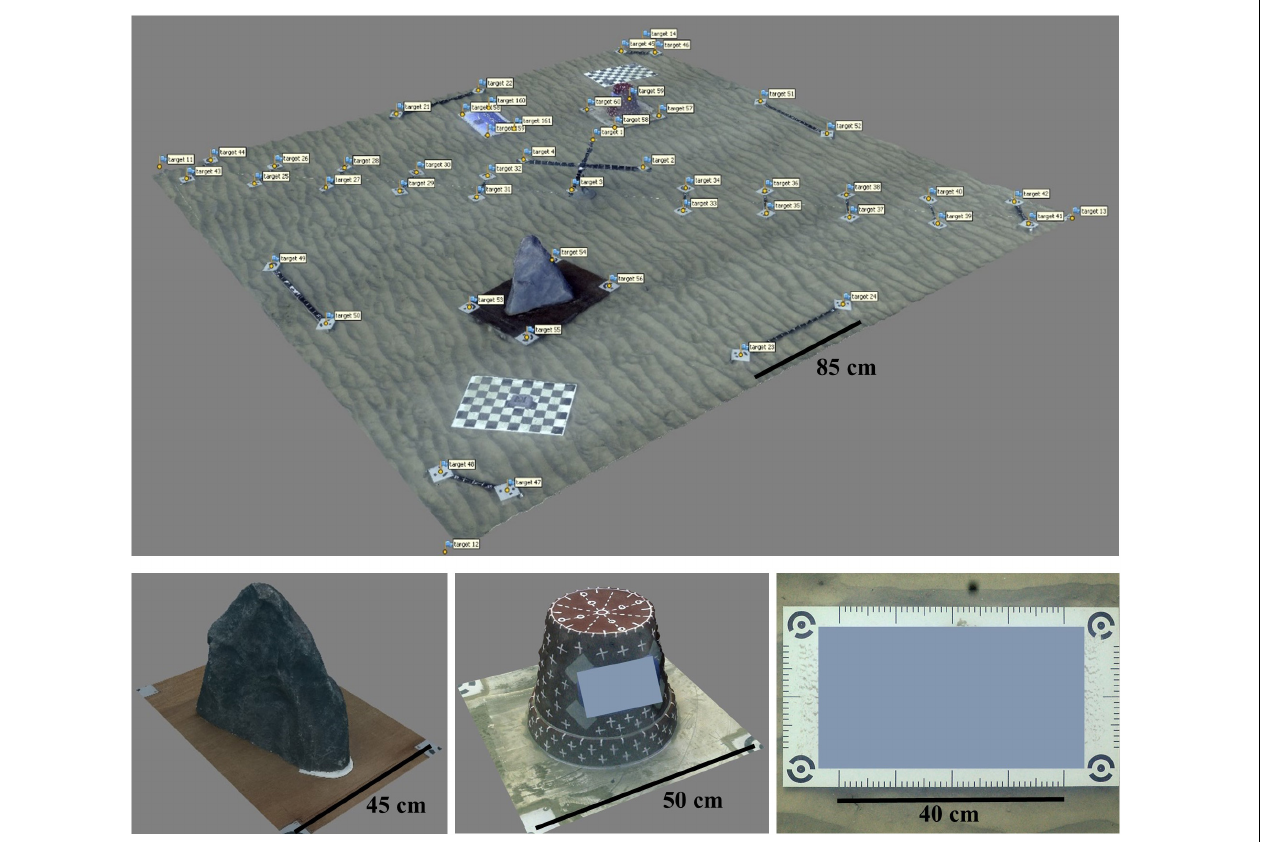
FIGURE 2 | Study site of experiment 2, sub-models of the rock, bucket, and the logo pane, with rulers.